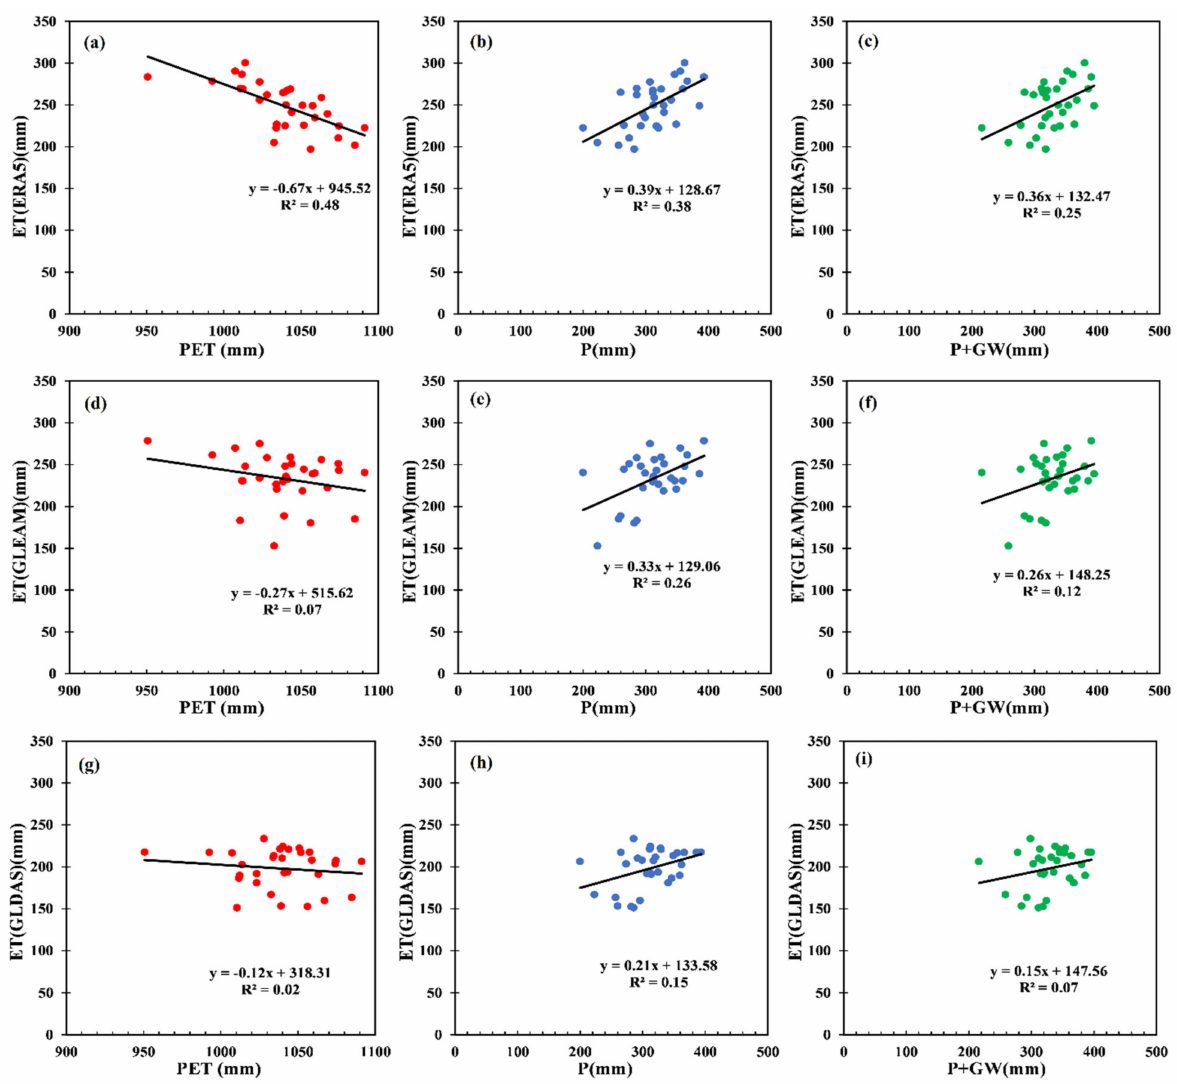
Figure 5. Correlation of annual evapotranspiration (ET) according to the ERA5 ( a,b,c ), GLEAM datasets ( d , e , f ), and, GLDAS datasets ( g , h , i ) with potential evapotranspiration (PET) ( a , c , g ), precipitation (P) ( b , d , h ), P + groundwater (GW) ( c , f , i ) over